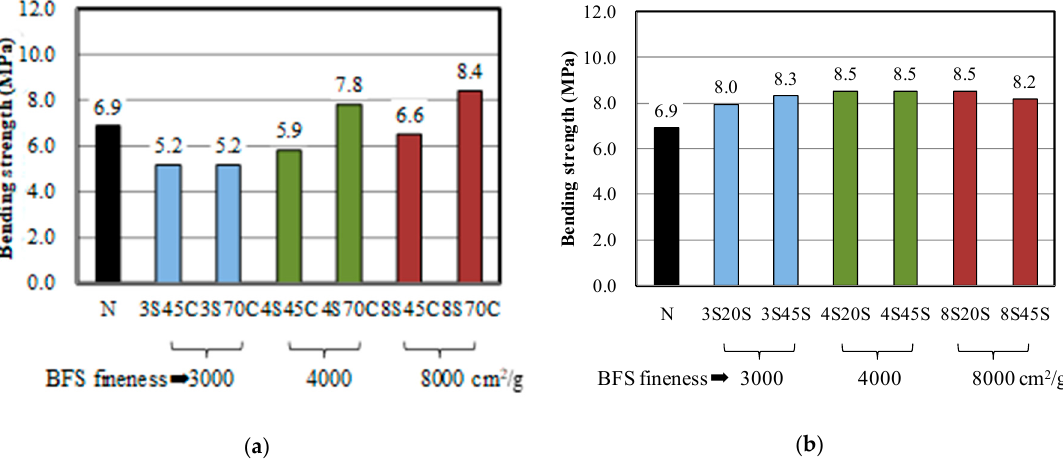
Figure 1. Bending strengths of mixtures made with different BFS replacement ratios: ( a ) BFS as a replacement for cement and ( b ) BFS as a replacement for sand.